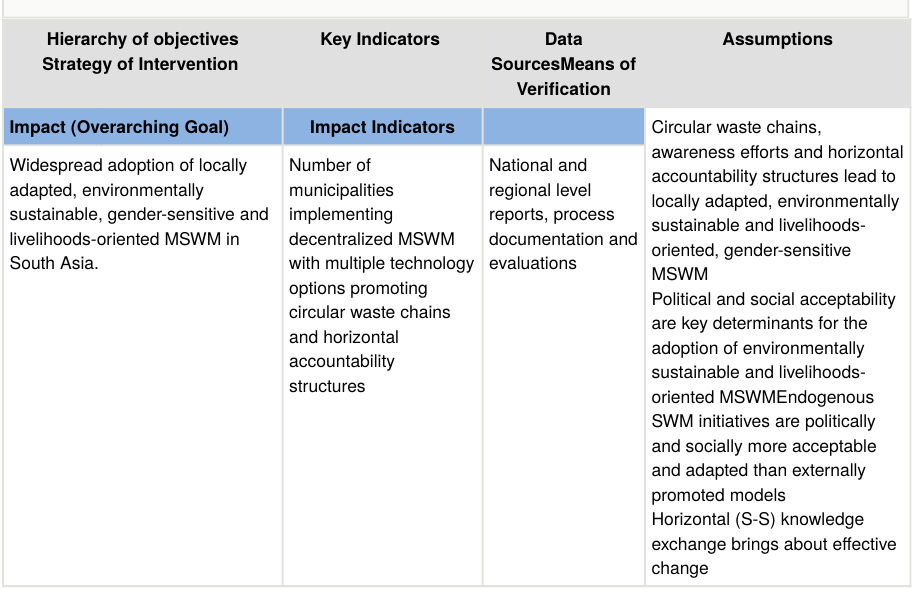
Results framework (project